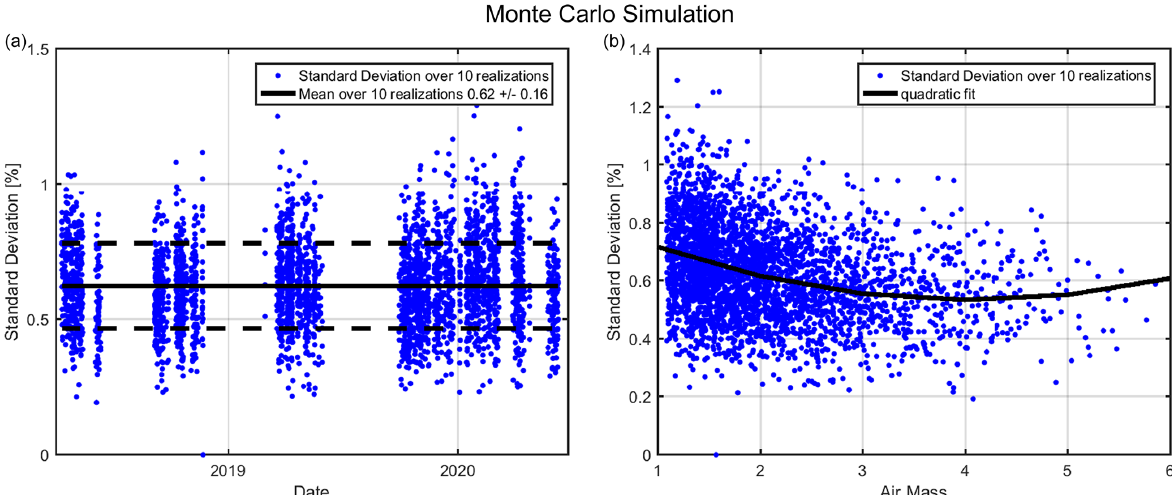
Figure 5. Results of the 32000 realizations of TCO from the Monte Carlo simulation. Panel (a) shows the standard deviation of 10 realizations for each measurement point and (b) indicates the dependency on air mass.